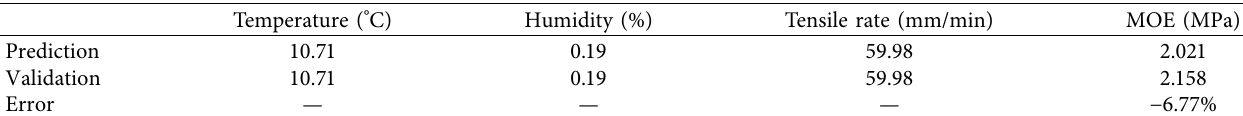
Figure 4is the 3D contour diagram of the MOE model;